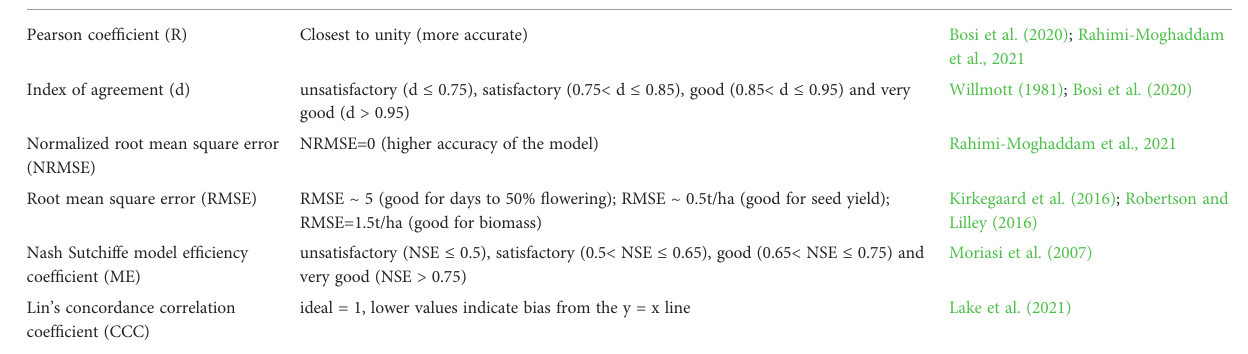
TABLE 1 Indicator of model.